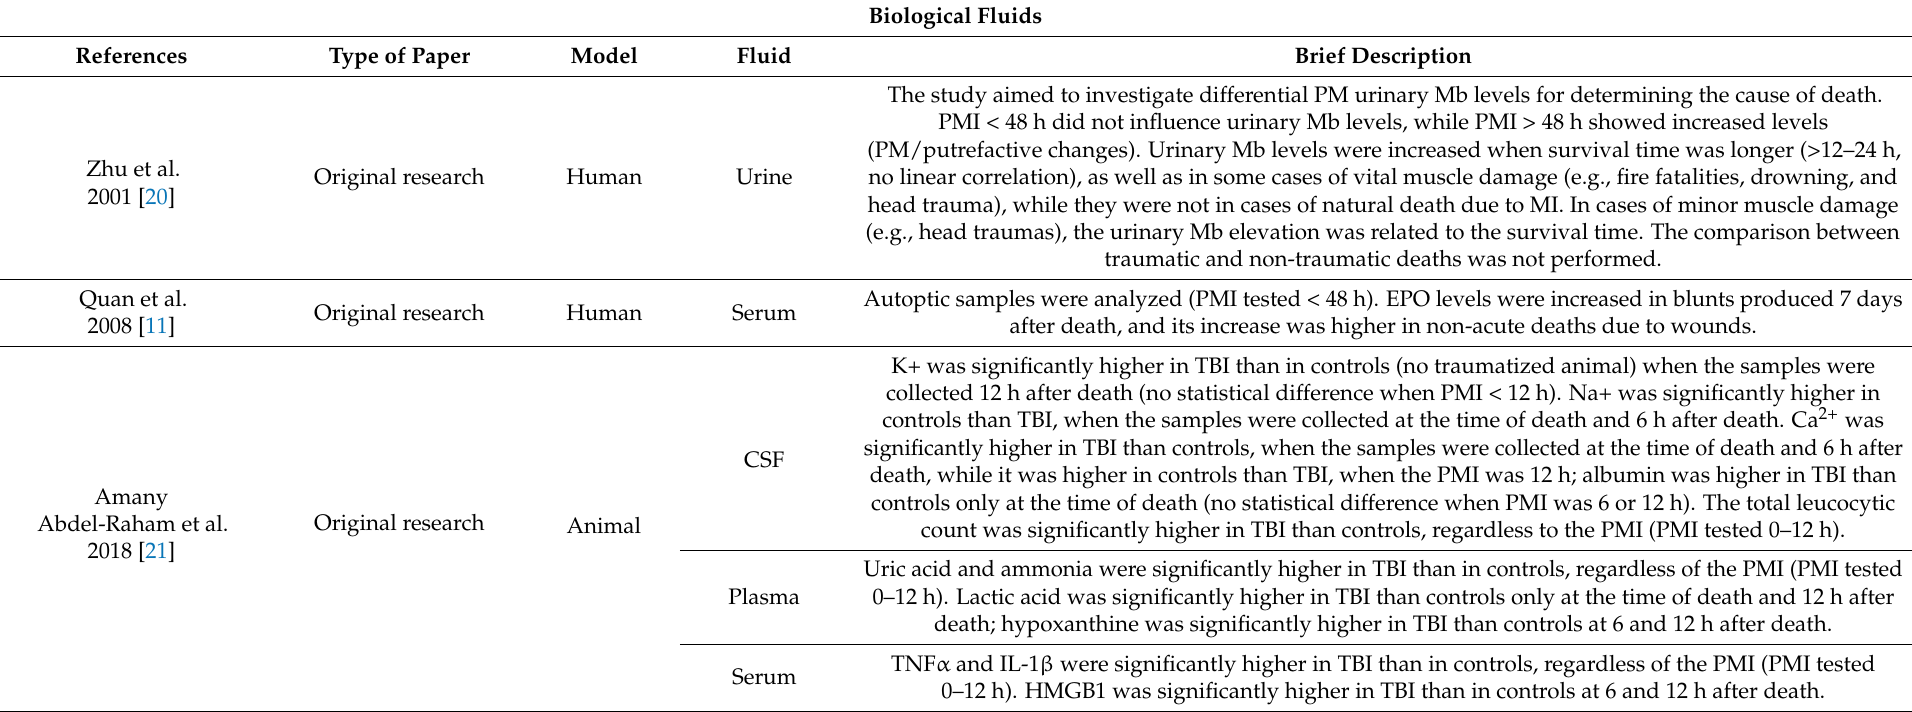
Table 1. The results of our review on vitality markers in biological fluids and tissues through quantitative analysis (24 articles). * These studies included different kinds of analyses, in order to investigate the differential protein expression in tissues, and they have been included in both the relative tables. α 7nAChR indicates α 7 nicotine acetylcholine receptor; ATF, activating transcription factors; CaMK II delta, calcium–calmodulin-dependent protein kinase II delta; CORT, corticosterone; CXC, keratinocytes-derived chemokine; CXCR, chemokine receptor; CRP, C-reactive protein; EPO, erythropoietin; HAX-1, HCLS1-associated protein X-1; HMGB1, high-mobility group box-1; IL-6, interleukin-6; LBP, lipopolysaccharide binding; LC3-II, lipid conjugated form II; LTB4, leukotriene B4; Mb, myoglobin; MI, myocardial infarction; MyoD, myoblast determination protein; MPO, myeloperoxidase; MT1-MMP, membrane type-1 matrix metalloproteinase; p62, sequestosome; Pax7, paired-box transcription factor 7; PCT, procalcitonin; RAGE, receptor for advanced glycation end products; sIL-2R, soluble interleukin-2 receptor; sTREM-1, soluble triggering receptors expressed on myeloid cells type 1; TIMP-2, tissue inhibitor of metalloproteinase-2; 1; VEGF, vascular endothelial grow factor; RT-PCR, real-time polymerase chain